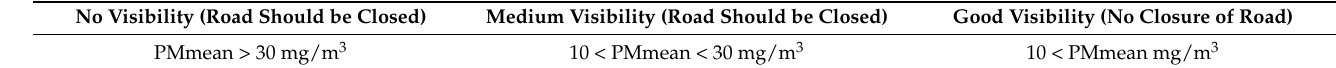
Table 2. Visibility and Road Accessibility.